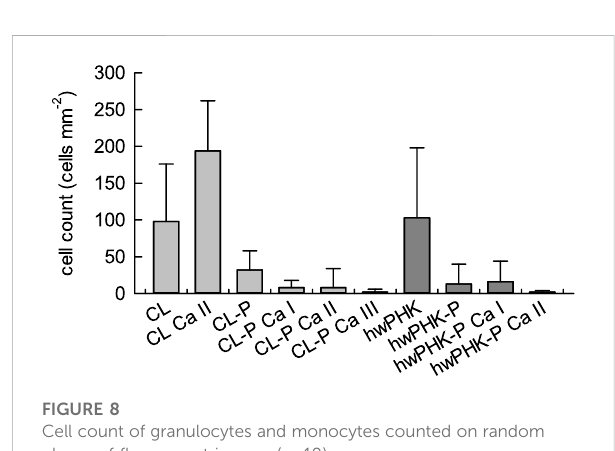
FIGURE 8 Cell count of granulocytes and monocytes counted on random places of fl uorescent images